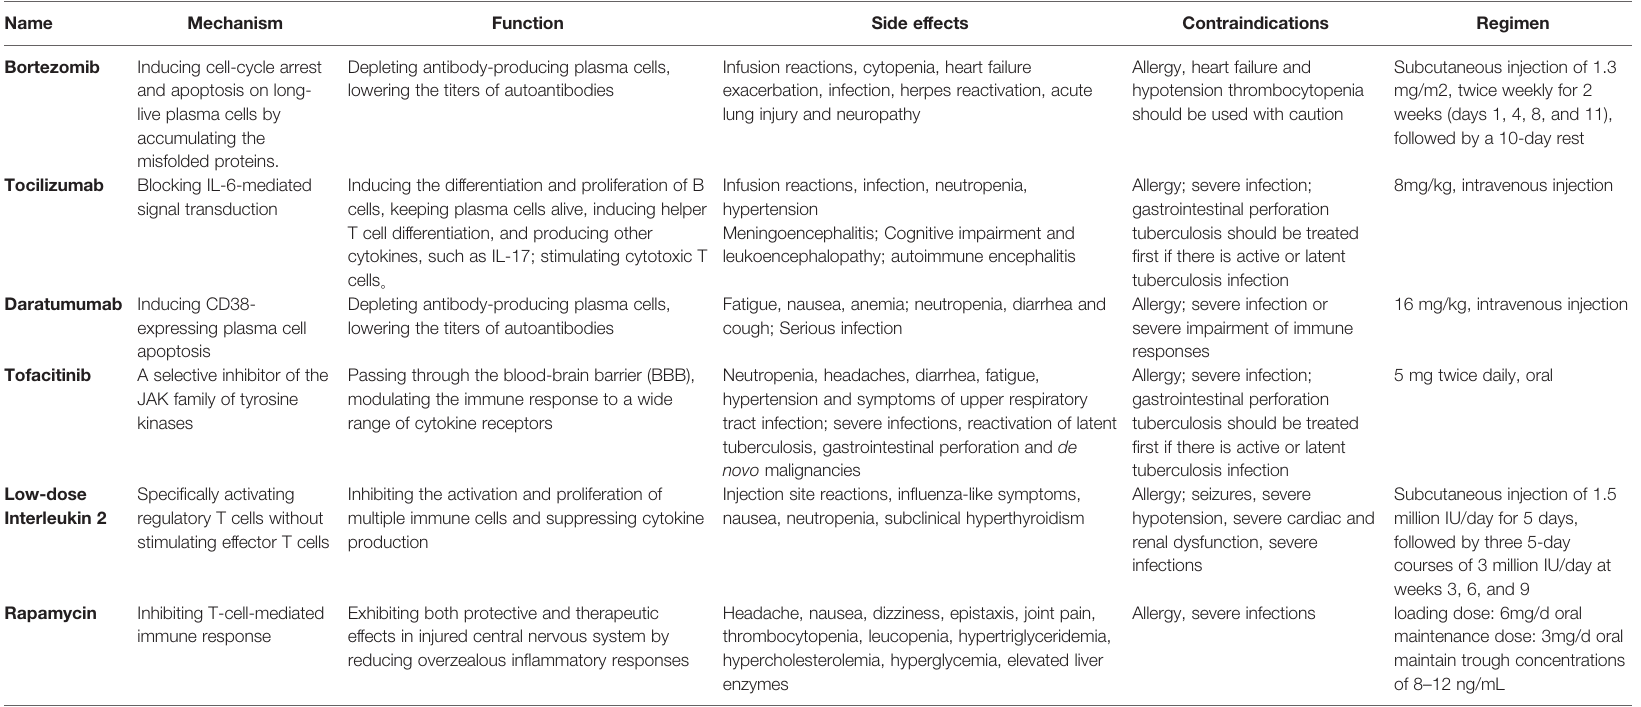
TABLE 1 | Overview of third-line therapy